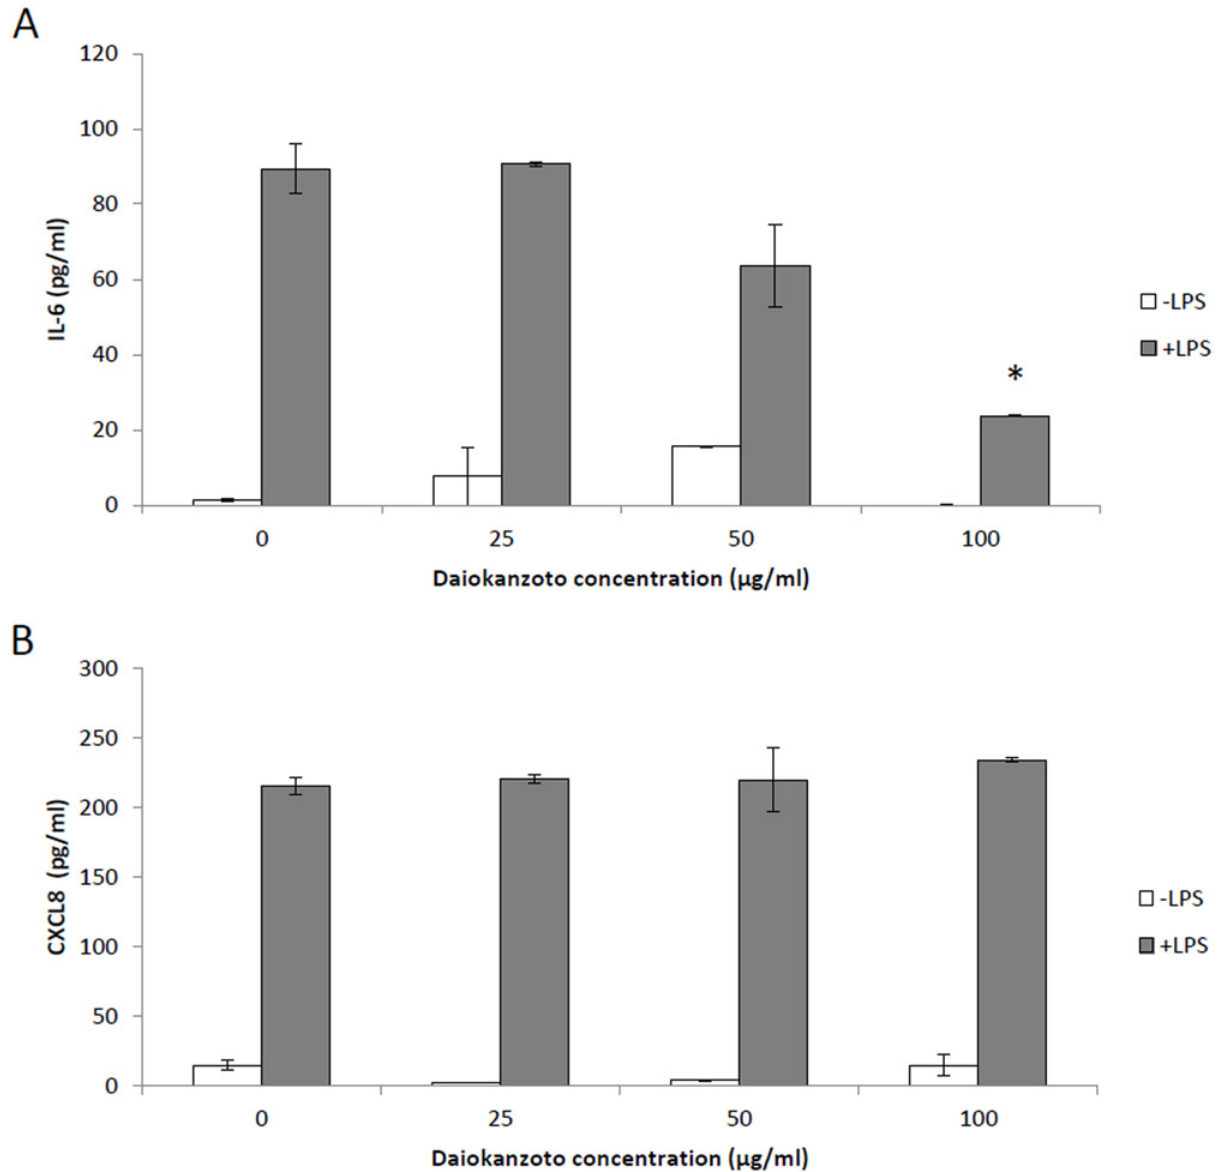
Fig 4. Effect of Daiokanzoto on IL-6 (Panel A) and CXCL8 (Panel B) secretion by LPS-stimulated human gingival fibroblasts (HGF-1). Data are expressed as means ± standard deviations. * , Significant inhibition at p < 0.01 using a Student ’ s t -test.